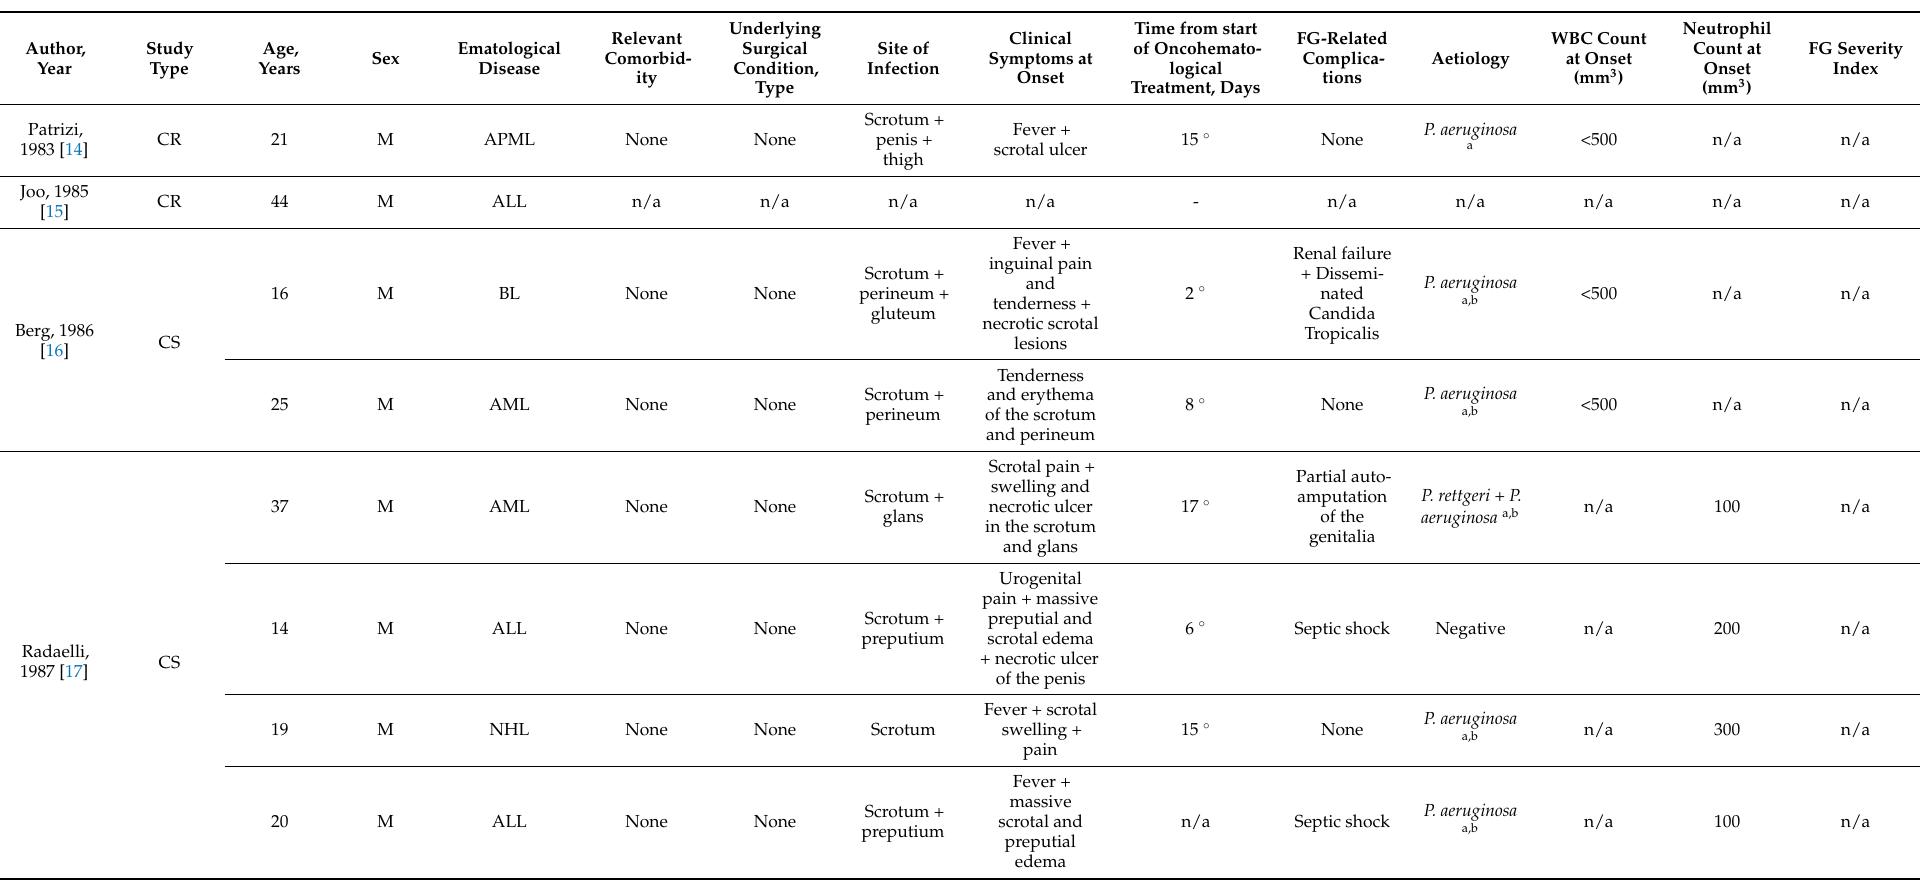
Table 1. Study characteristics and patients’ clinic-pathologic